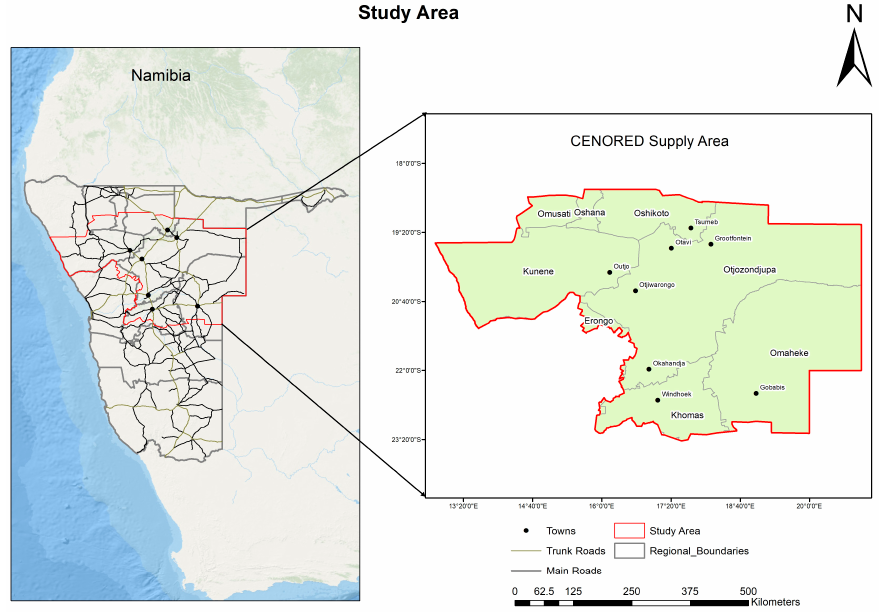
Figure 2. Central North region of Namibia—the study